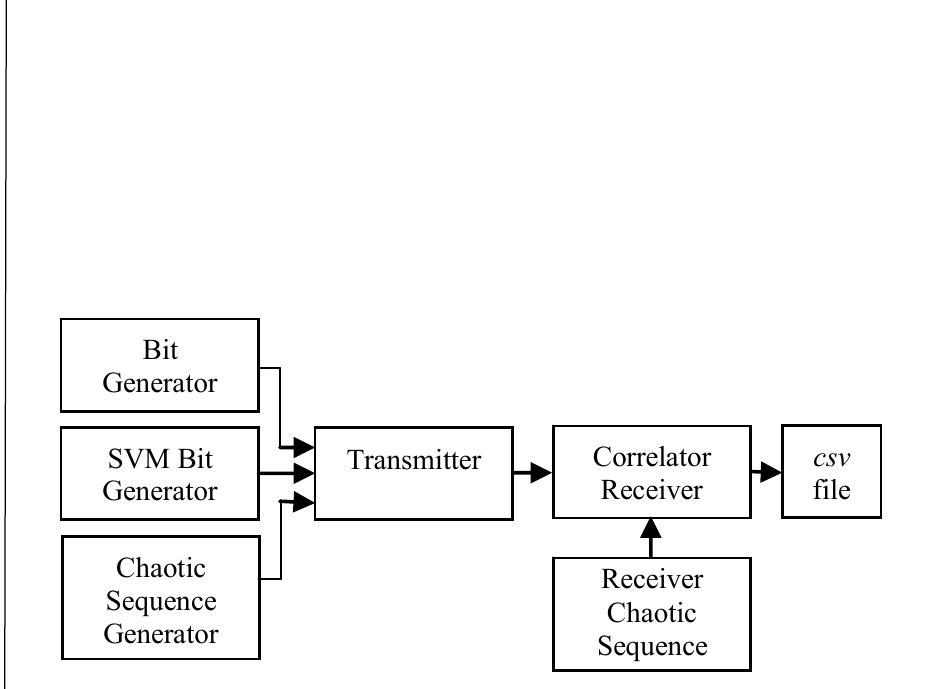
Figure 4 – Functional block diagram of the system for the training phase Рис . 4 – Функциональная блок - схема системы для фазы подготовки Slika 4 – Principski blok dijagram sistema u fazi